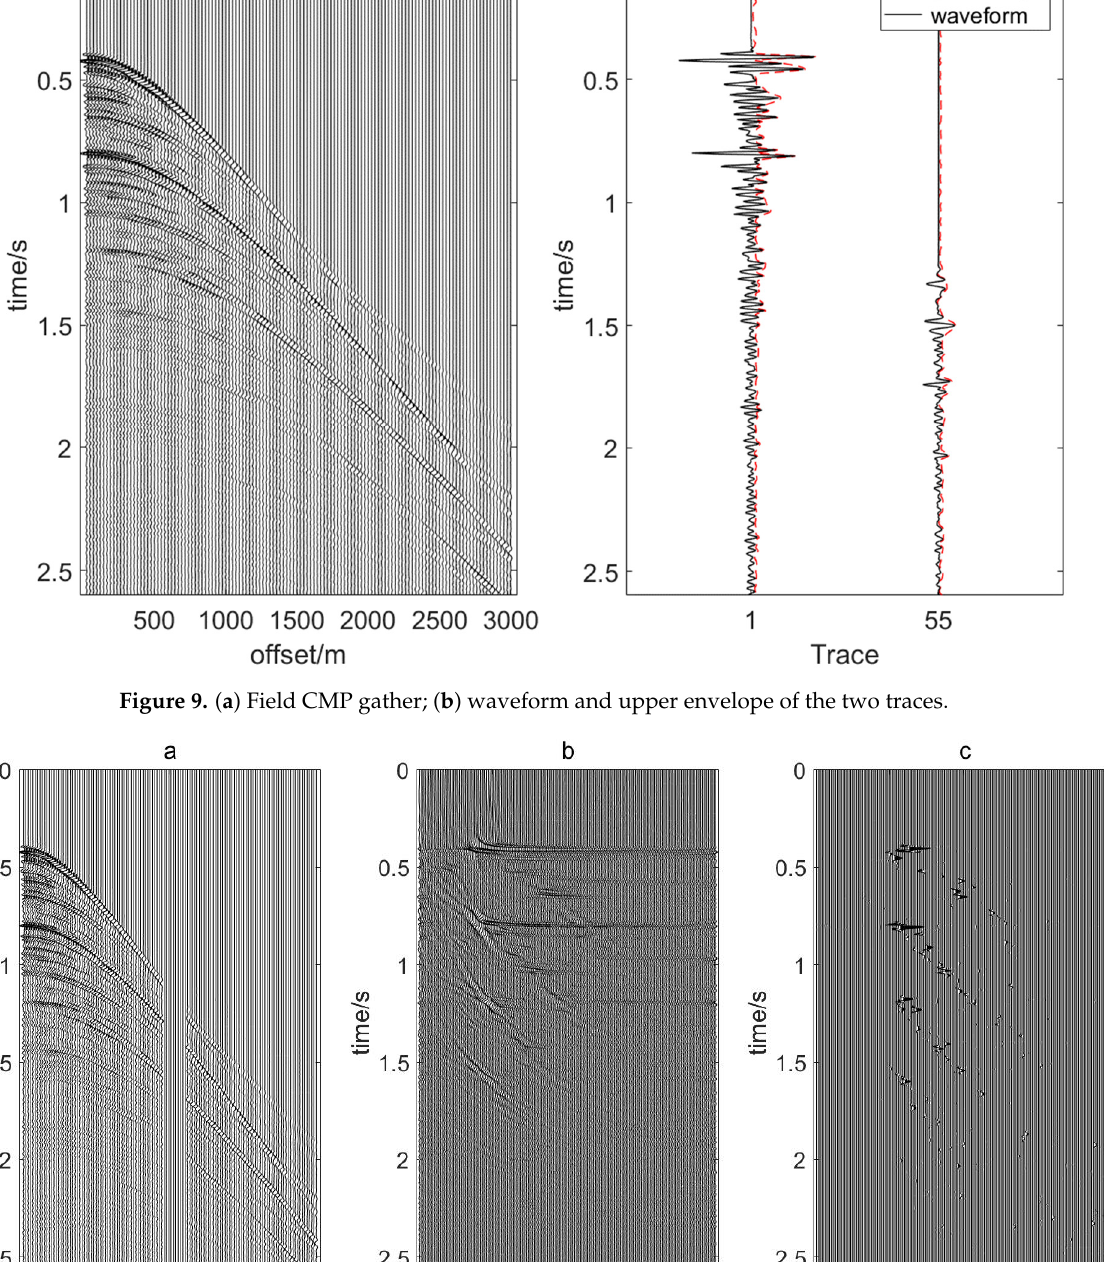
Figure 11. ( a ) CGRT inverse transform result; ( b ) WRT inverse transform result. Figure 12 shows the waveform of the original data and the inversion results at trace 10 and trace 64 at the reconstruction region. The black line represents the original data, while the red line and the blue line represent CGRT and WRT, respectively. Compared with the CGRT, for the field data, the WRT kept the waveform more accurate and pre- served the AVO. The SNR of the reconstructed results for the CGRT and for the WRT are 4.32 dB and 9.71 dB, respectively.